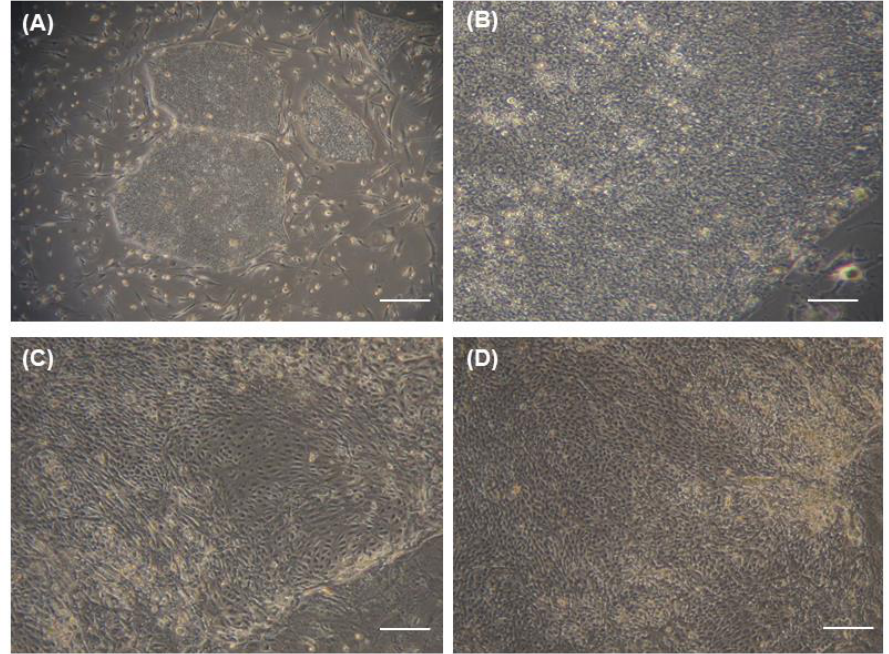
Figure 3. Morphologic changes of cultured human iPS cells. Bright-field microscopy images of undifferentiated human iPS cell cultures at ( A ) low-magnification (10×); scale bar = 500 μm) and ( B ) high-magnification (100×). Bright-field microscopy images of human iPS cells differentiated in ( C ) limbal-specific (PI) medium only (100×) and ( D ) PI medium with the optimal BMP4 treatment (100×). Scale bar = 50 μm ( B – D ).